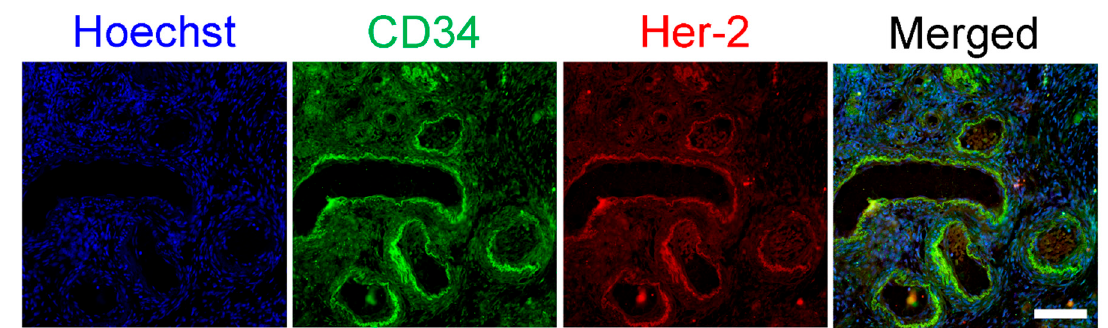
Figure 6. HER2/neu vascular expression in human ovary. Ovaries were fixed, paraffin-embedded and serially sectioned for immunofluorescence. Representative fluorescence images of ovary co-stained against CD34 (green) and Her-2 (Red). Bar = 100 µm.